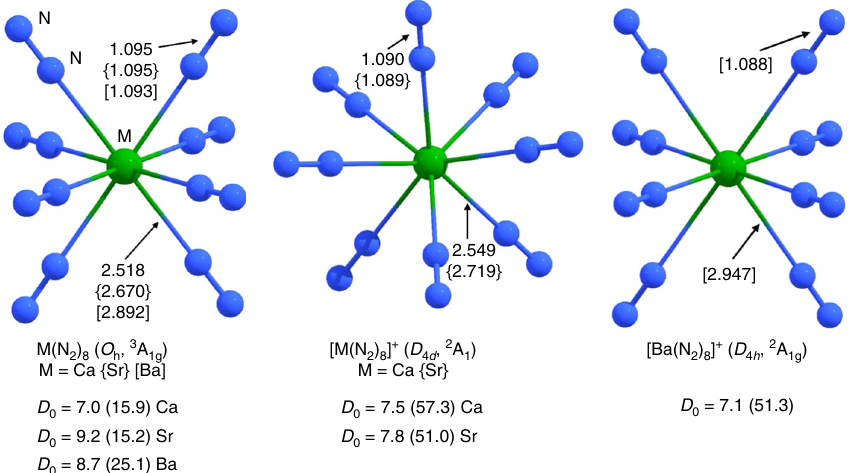
Fig. 2 Calculated geometries and bond lengths. Calculated equilibrium structures and interatomic distances [Å] of M(N 2 ) 8 and [M(N 2 ) 8 ] + (M = Ca, Sr, Ba) at the M06-2X-D3/def2-TZVPP level. Bond dissociation energies D 0 [kcal mol − 1 ] for loss of one N 2 and (in parentheses) loss of eight N